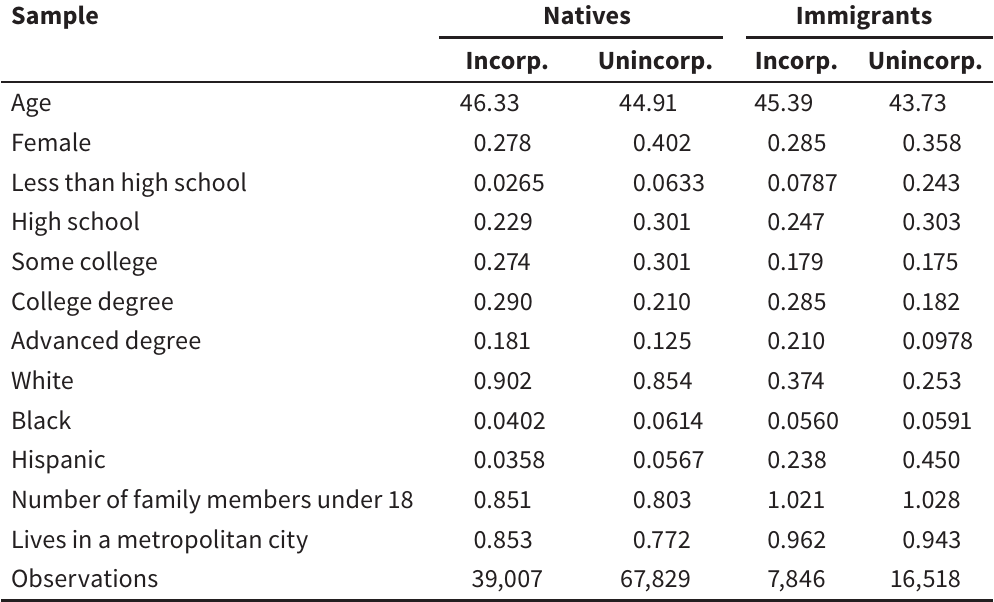
Table 2 Summary statistics: incorporated vs. unincorporated